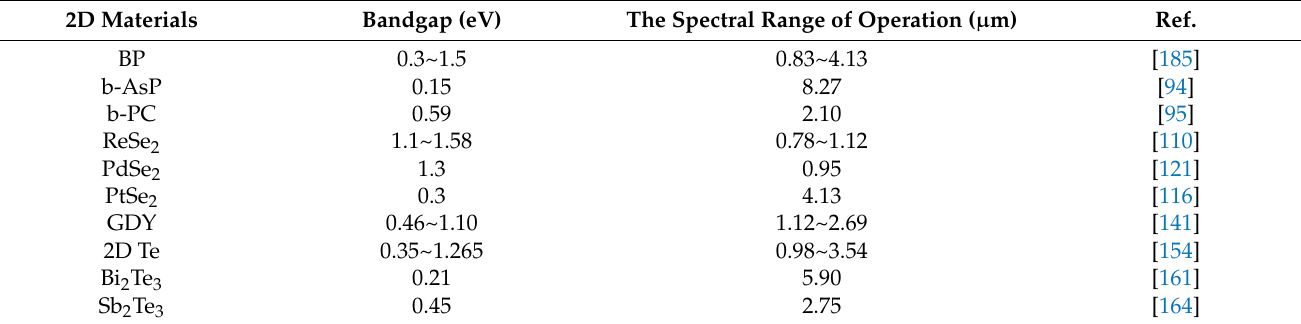
Figure 2. ( a ) Normalized PL spectra of BP from 1 to 5 layers. ( b ) PL peak energy of different layers [185]. Copyright 2015 Nature Publishing Group. ( c ) Relationship between peak intensity and number of layers [186]. Copyright 2014 American Chemical Society. ( d ) Single layer BP diagram coupled with quantum emitter. ( e ) Double-layer BP diagram coupled with quantum emitter [187]. Copyright 2017 The Optical Society. ( f ) Embedded DBR microcavity embedded with BP nanosheets. ( g ) The cross-section view of microcavity embedded with BP inSEM image. ( h ) BP crystalline structure. ( i ) DBR and the SiO cavity transmission spectrum caught in the bottom and up DBRs. ( f – i ) Reproduced with permission from Ref. [188]. Copyright 2020 Wiley-Blackwell. Table 1. The spectral range of operation of some representative